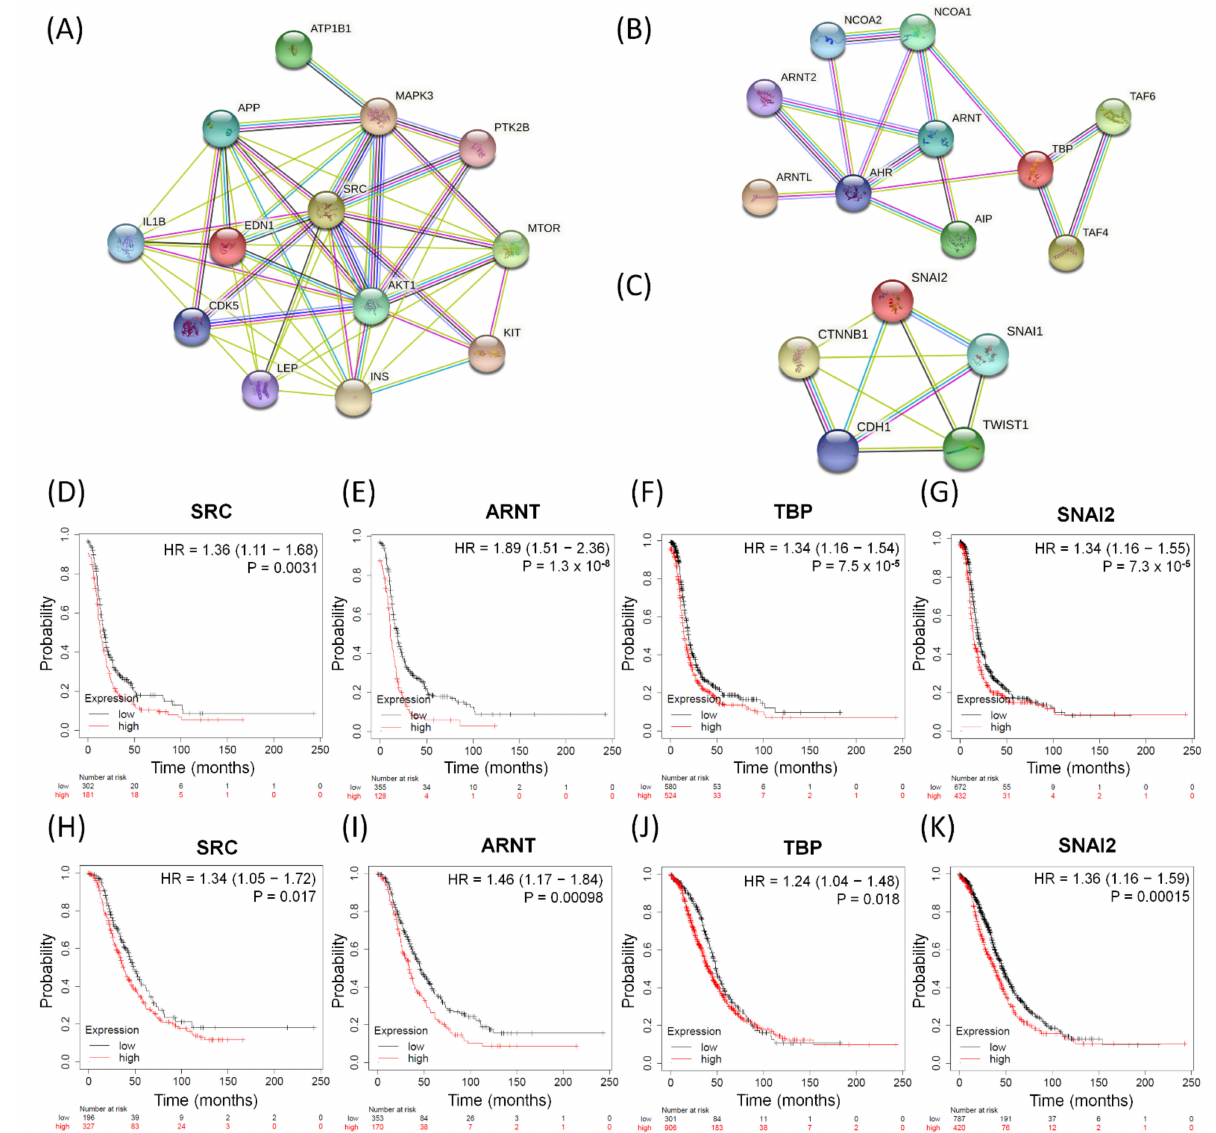
Figure 3. The significant biomarkers influencing serous ovarian tumors. ( A – C ) Panels display identified potential in- volving DEGs subjected to protein–protein interaction (PPI) analysis with interactive network from the STRING database (https://string-db.org (accessed on 21 July 2021)) with intensive interactions. ( A ) All 13 relevant DEGs sorted from the top 25 common dysregulated GO terms, ( B ) all ten DEGs in-volved in dysfunctional aryl hydrocarbon receptor (AHR) binding pathway, and ( C ) five featured DEGs among relevant biomarkers associated with EMT. ( D – K ) The four meaningful DEGs (SRC, ARNT, TBP and SNAI2) associated with poor survival outcomes. PFS: ( D ) SRC, ( E ) ARNT, ( F ) TBP, ( G )